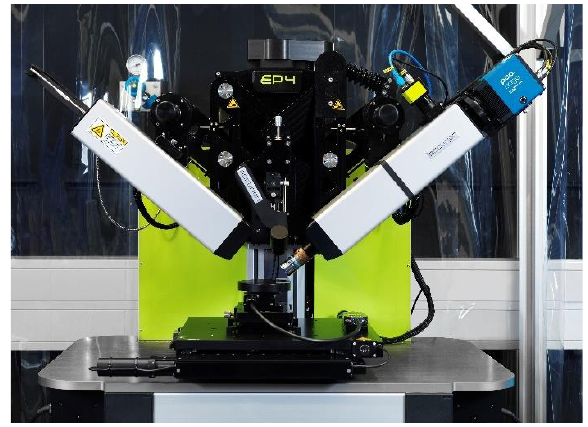
Fig. 1. Imaging Mueller matrix ellipsometer from Accurion .